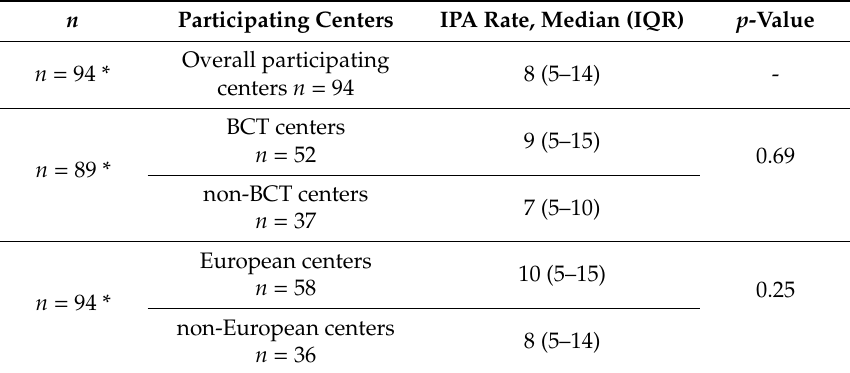
Table 4. Median estimated invasive pulmonary aspergillosis (IPA) rates.